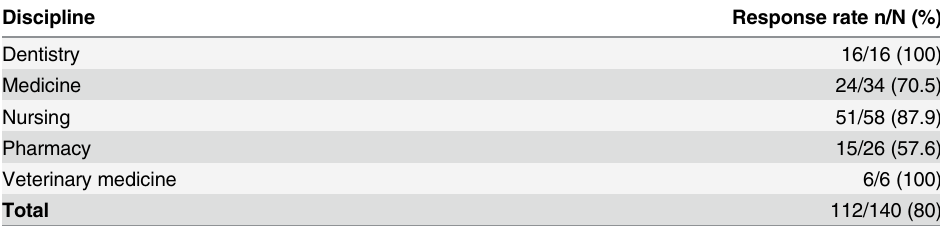
Table 1. Number of participating courses, by discipline.